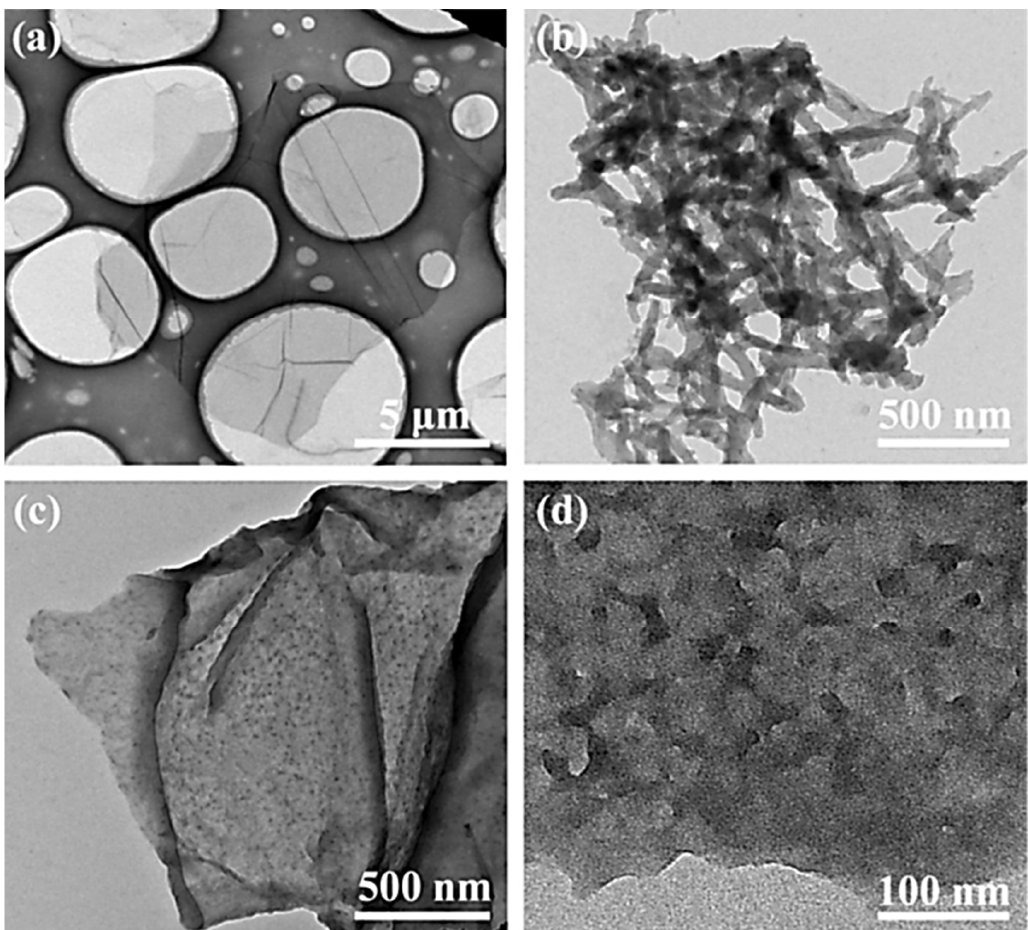
Figure 4. ( a ) TEM images of SG, ( b ) PANI and ( c , d ) PANI/SG at 500 nm and 100 nm [70]. PANI = polyaniline; SG = sulfonated graphene.